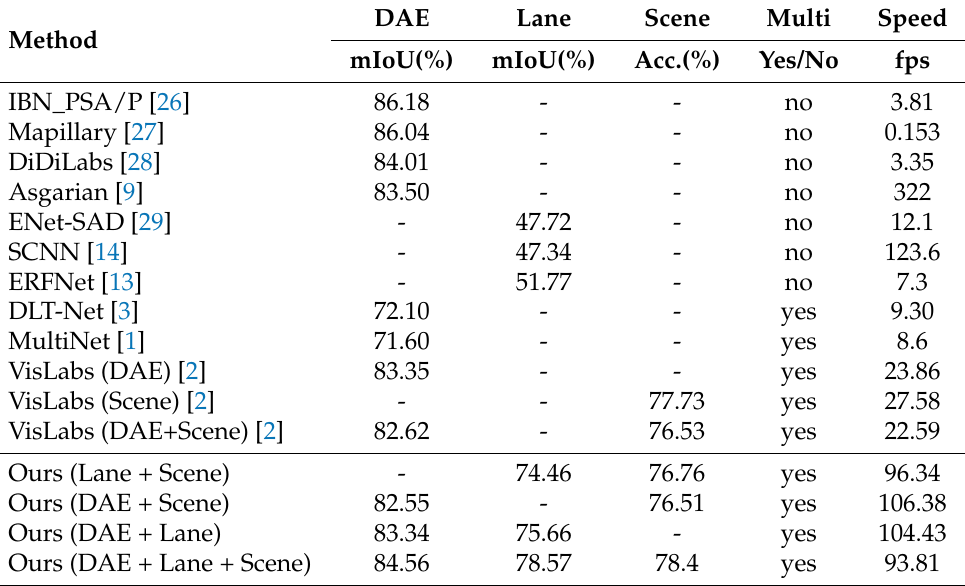
Table 2. Quantitative evaluation on the BDD dataset. DAE, Lane, Scene, Multi, and Speed refers to the drivable area estimation task, lane line segmentation task, scene classification task, multi-task learning, and running time,